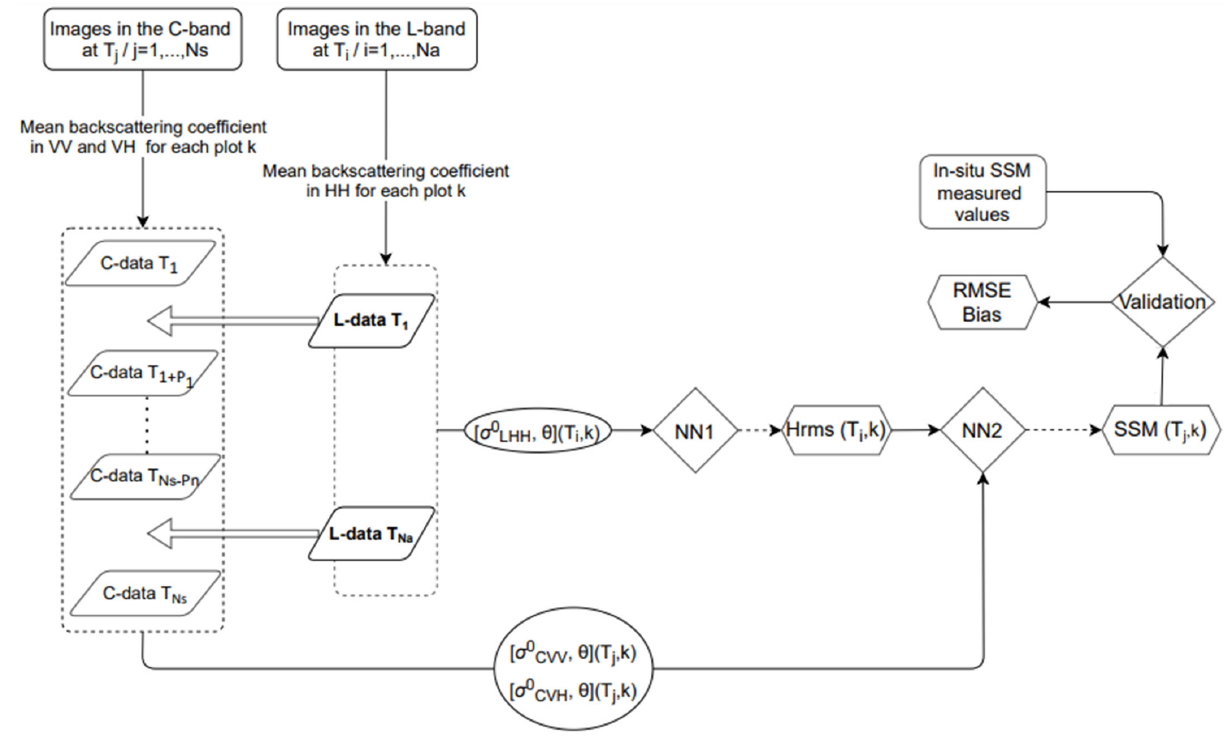
Figure 2. Methodological flowchart of the integration of soil roughness (Hrms) estimated from L ‐ band SAR data into the NNs retrieval approach of bare soil moisture from C ‐ band SAR data. Ti are the dates of L ‐ band images, Tj are the dates of C ‐ band images. Ns is the number of the Sentinel ‐ 1 images in the C ‐ band, Na is the number of ALOS images in the L ‐ band, P1 is the period in which estimated Hrms from L ‐ band data is considered stable, θ is the SAR incidence angle.